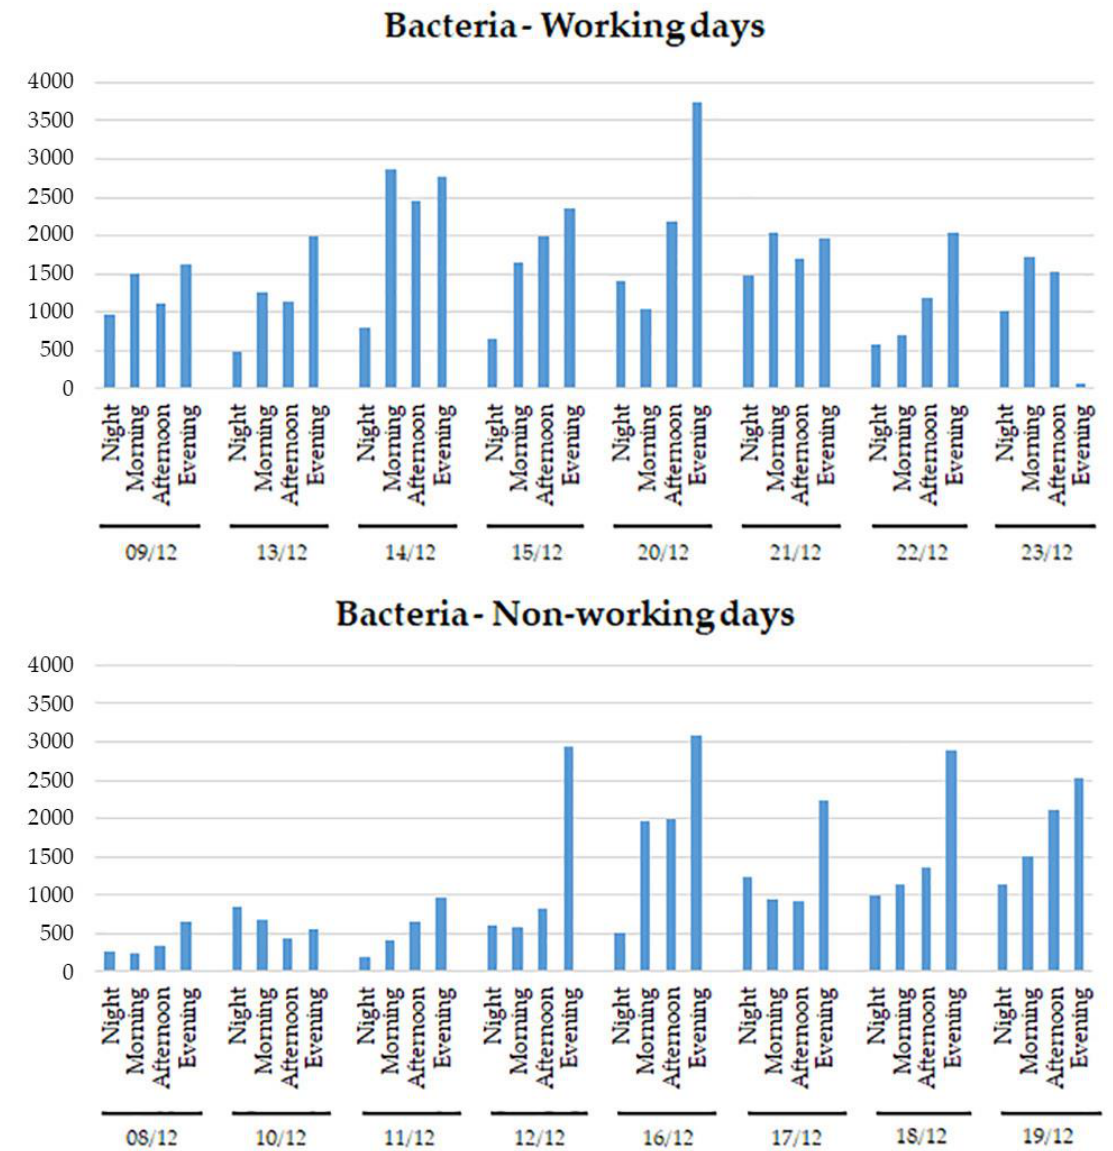
Figure 10. Number of bacteria-related particles ( y -axis) for each day and each part of the day ( x -axis). Working (WDs) and non-working days (NWDs) are shown separately.